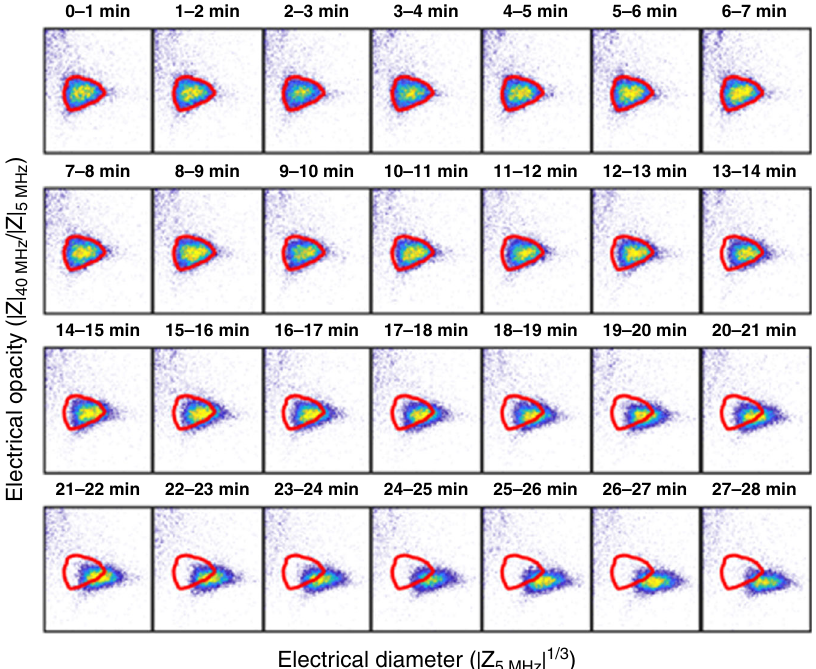
Fig. 2 Time course of changes in electrical properties of K. pneumoniae following β -lactam exposure. A sample of a Meropenem-susceptible strain of K. pneumoniae was exposed to Meropenem at 2 mg/L. The sample was maintained at a temperature of 37 °C and measured continuously for 30 min. The data was segmented into 1 min intervals and plotted as a series of scatter plots. Cells measured in the fi rst minute were used to de fi ne the reference contour shown in red. Note that the x- and y- axis limits are identical for all fi gures (not shown for clarity) and are 1.2 – 3.0 ( x- axis) and 0.4 – 0.9 ( y- axis). Source data are provided as a Source Data fi